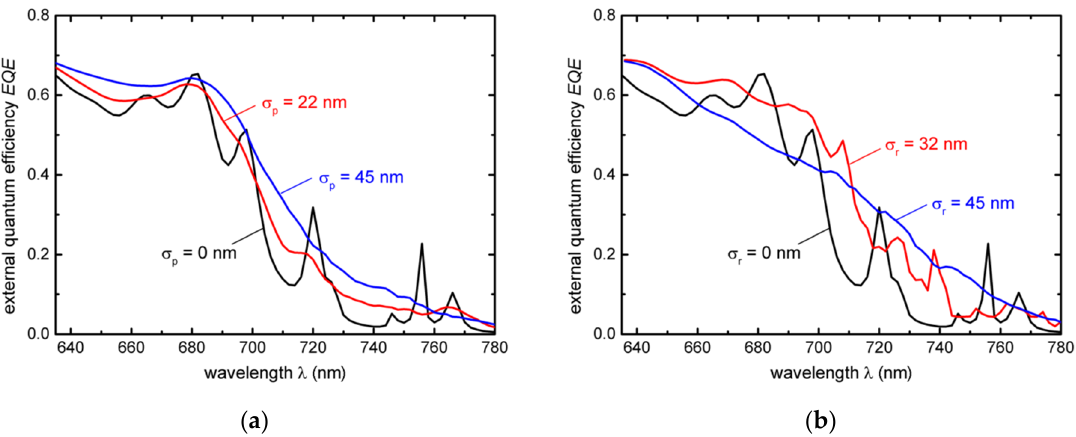
Figure 5. ( a ) External quantum efficiency of a-Si:H solar cells with different degrees of position disorder in the grating textures. The position disorder is parameterized by the Gaussian width σ p . ( b ) External quantum efficiency of a-Si:H solar cells with different degrees of radius disorder in the grating textures. The radius disorder is parameterized by the Gaussian width σ r